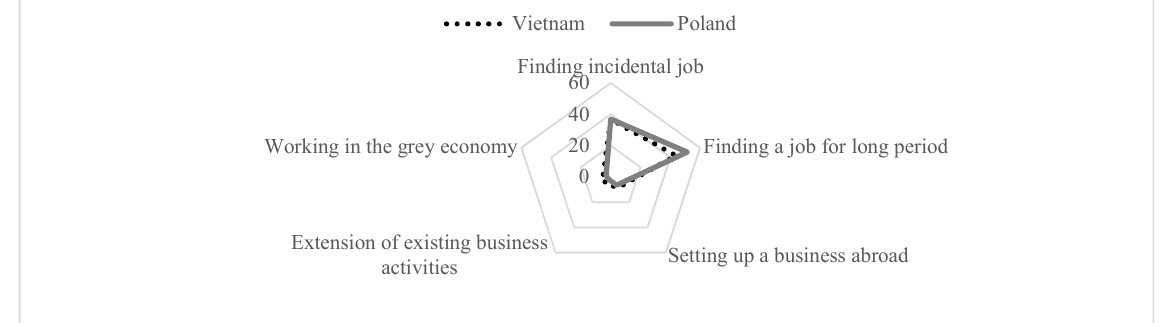
Fig. 3. The purpose of Vietnamese and Polish respondents in case of going